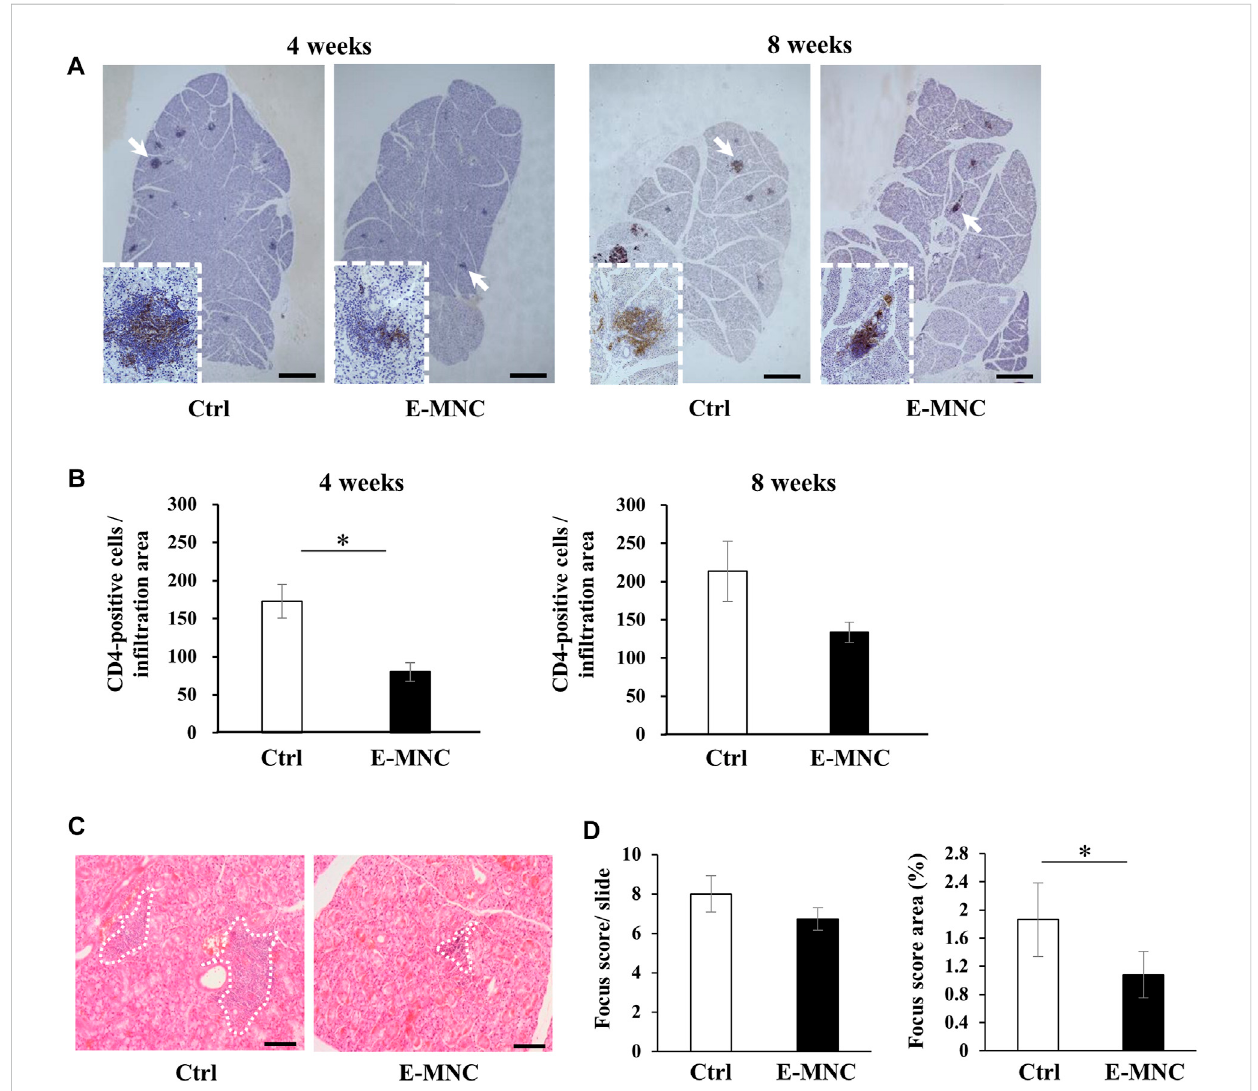
FIGURE 6 Lymphocyte in fi ltration after E-MNC treatment. (A) CD4 staining of submandibular glands in non-treated mice (Ctrl) and E-MNC – treated mice (E-MNC)at4and8 weekspost-transplantation(scalebar,1,000 μ m).CellspositiveforCD4(T-helpercells)appearbrowninthefoci. (B) NumberofCD4- positive cells in lymphocyte in fi ltrated areas at 4 and 8 weeks (* p < 0.05). (C) H&E staining of submandibular glands in non-treated mice (Ctrl) and E-MNC – treatedmice(E-MNC)at4and8 weekspost-transplantation(scalebar,200 µm).Whitedottedlinesindicatetheportionusedtodetermine the focus score. (D) Focus score and area in non-treated mice (Ctrl) and E-MNC – treated mice (E-MNC) (* p < 0.05). For statistical analysis, the Student ’ s t-test was performed to determine the signi fi cance of differences among Ctrl- and